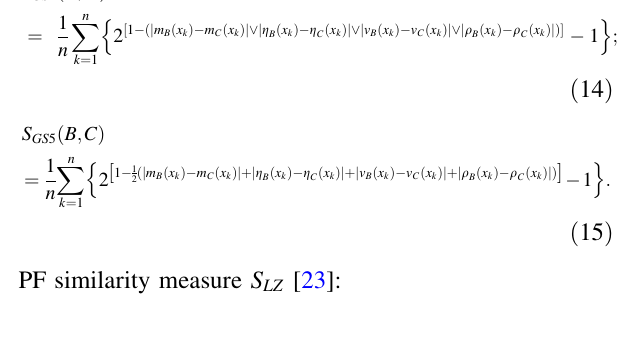
ffiffiffiffiffiffiffiffiffiffiffiffiffiffiffiffiffiffiffiffiffiffiffiffiffiffiffiffi p ffiffiffiffiffiffiffiffiffiffiffiffiffiffiffiffiffiffiffiffiffiffiffiffiffiffi m B x k ð Þ m C x k ð Þ 2